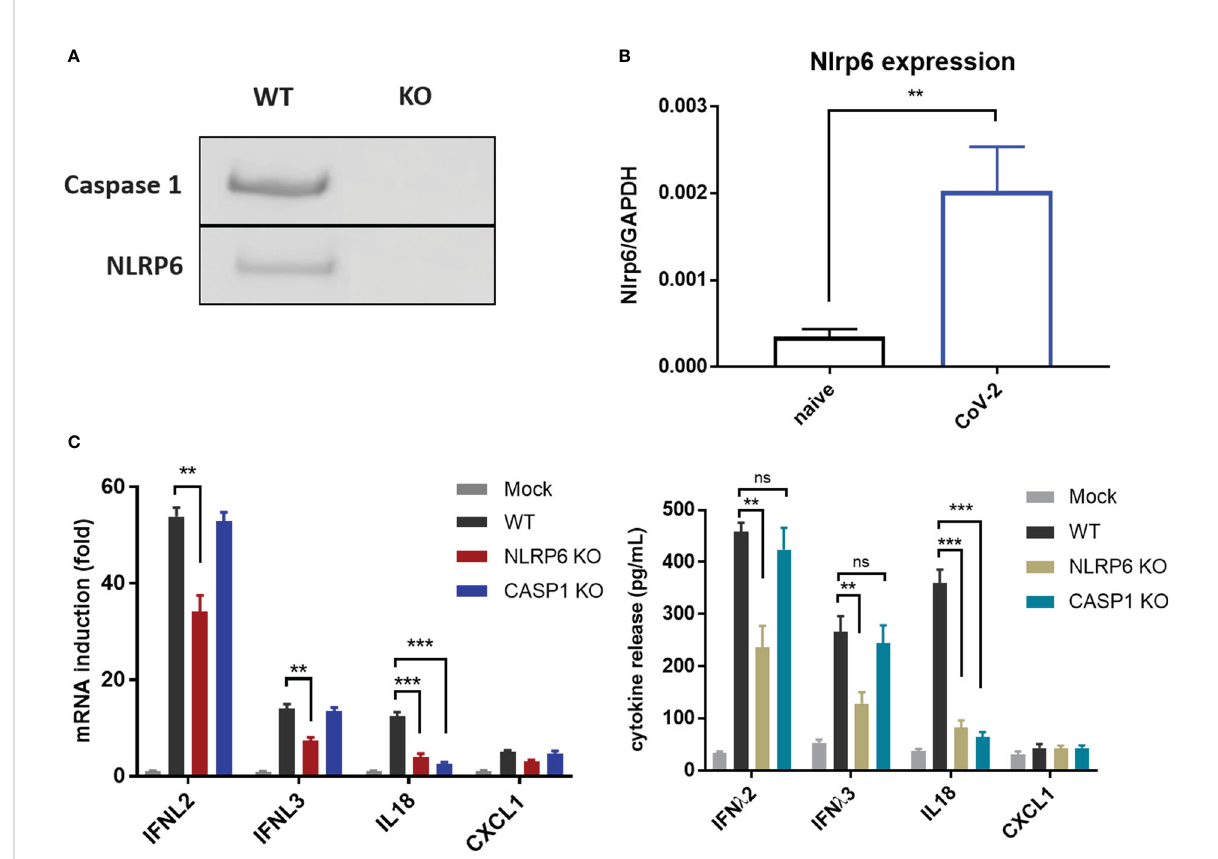
FIGURE 5 NLRP6 participated in the regulation of CoV-2 induced cellular immunity in IECs. (A) NLRP6 is constitutively expressed in Caco-2-ACE2-N cells. Western blot showing knockout ef fi ciency of Caspase1 or NLRP6 by CRISPR-Cas9 system in Caco-2-ACE2-N cells. (B) Caco-2-ACE2-N cells were infected with CoV-2 at 0.5 MOI. At 16 hpi, mRNA level of nlrp6 was quanti fi ed by qRT-PCR. (C) The immune response pro fi le of Nlrp6 or Casp1 knockout Caco-2-ACE2-N cells infected with CoV-2 for 48h. mRNA expression of anti-viral and in fl ammatory cytokines were determined by qPCR. Anti-viral and in fl ammatory cytokine release were con fi rmed at protein level by ELSIA. Data are represented as mean ± SEM of four replicates. Statistical signi fi cance is indicated. (ns, not signi fi cant, **p<0.01 ***p<0.001, unpaired t